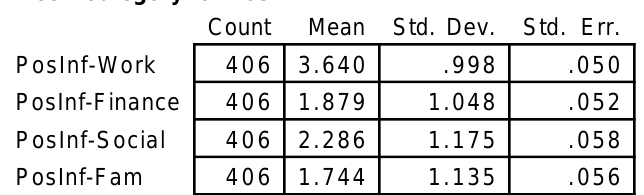
Effect: Category for